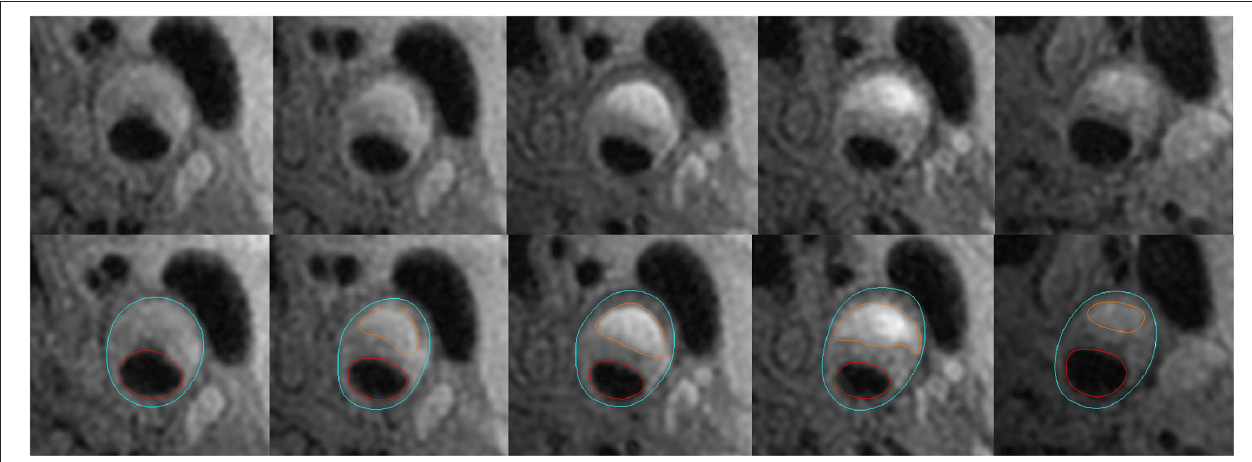
FIGURE 1 | Example for measurements of carotid plaque-containing vessel wall volume and IPH volume. The figure shows that the lumen in red and outer wall boundary in blue of the carotid artery are identified and outlined on T1-weighted images. Carotid plaque-containing vessel wall volume is calculated by multiplying the slice thickness (2mm) by the sum of the areas between the red and blue circles in slices with a vessel wall thickness of at least 2mm. IPH volume is calculated by multiplying the slice thickness (2mm) by the sum of the areas circled in orange